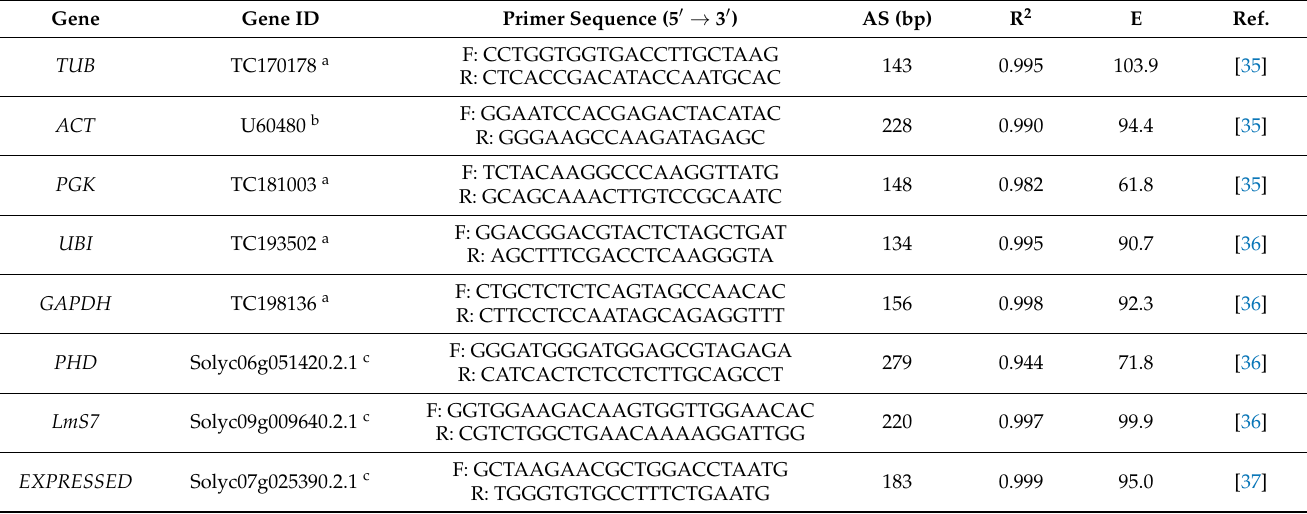
Table 1. Reference genes and primers used in qPCR.